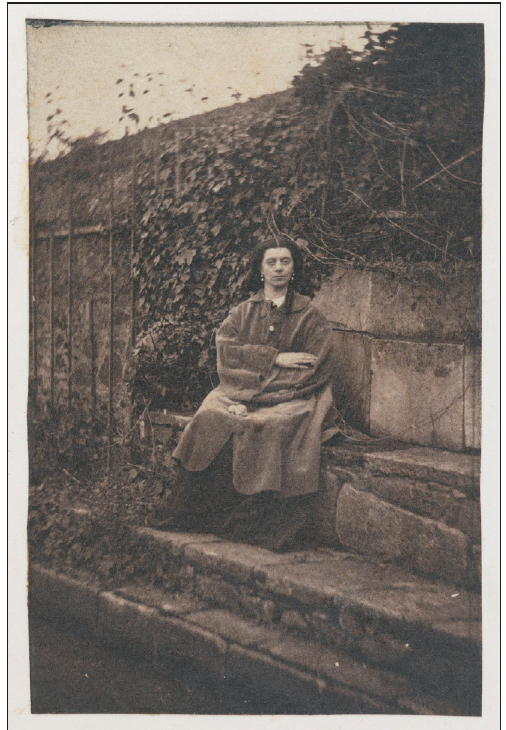
Fig. 4 : Alphonsine de Saint-Amand, 1860, photograph. CC0 Paris Musées/Mai- sons de Victor Hugo Paris-Guernesey.